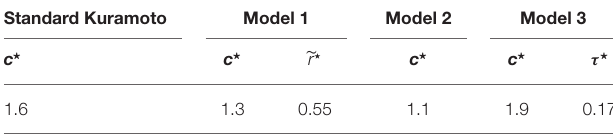
TABLE 3 | Optimal parameter values for each